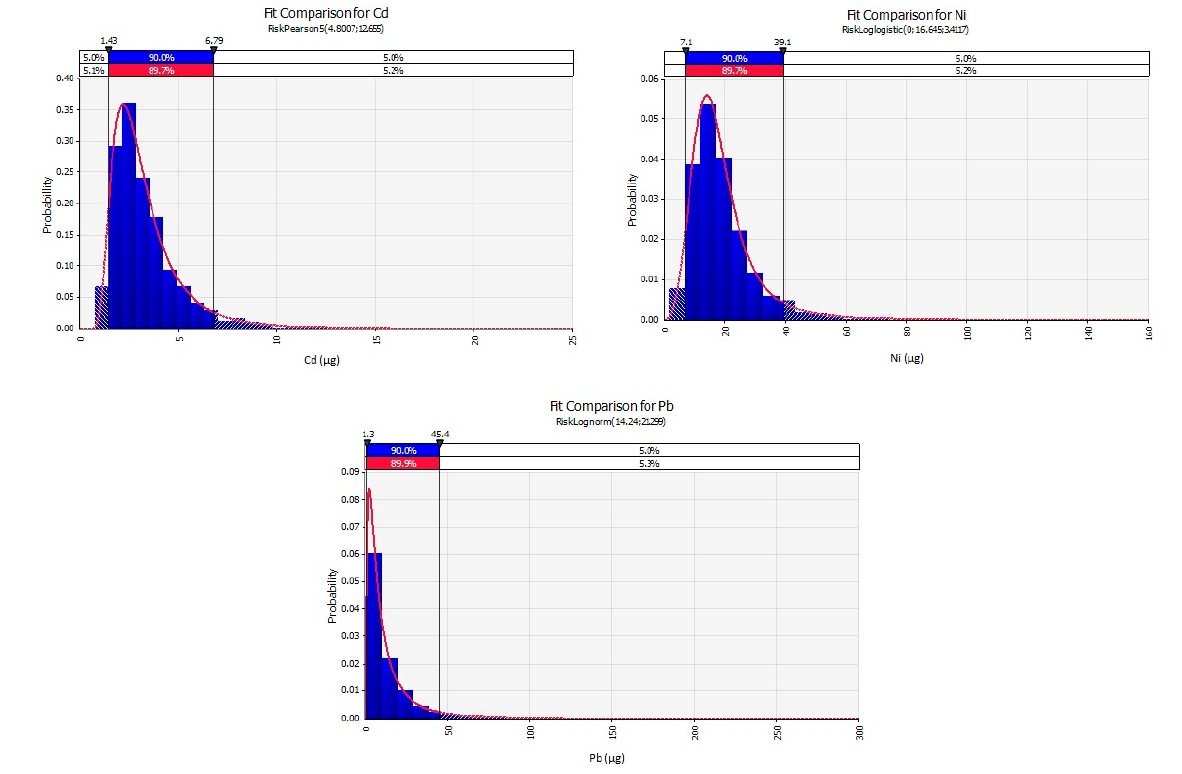
Figure 4. Simulated data and fitted probabilistic distribution for Cd, Ni and Pb in conventional Brassicas.